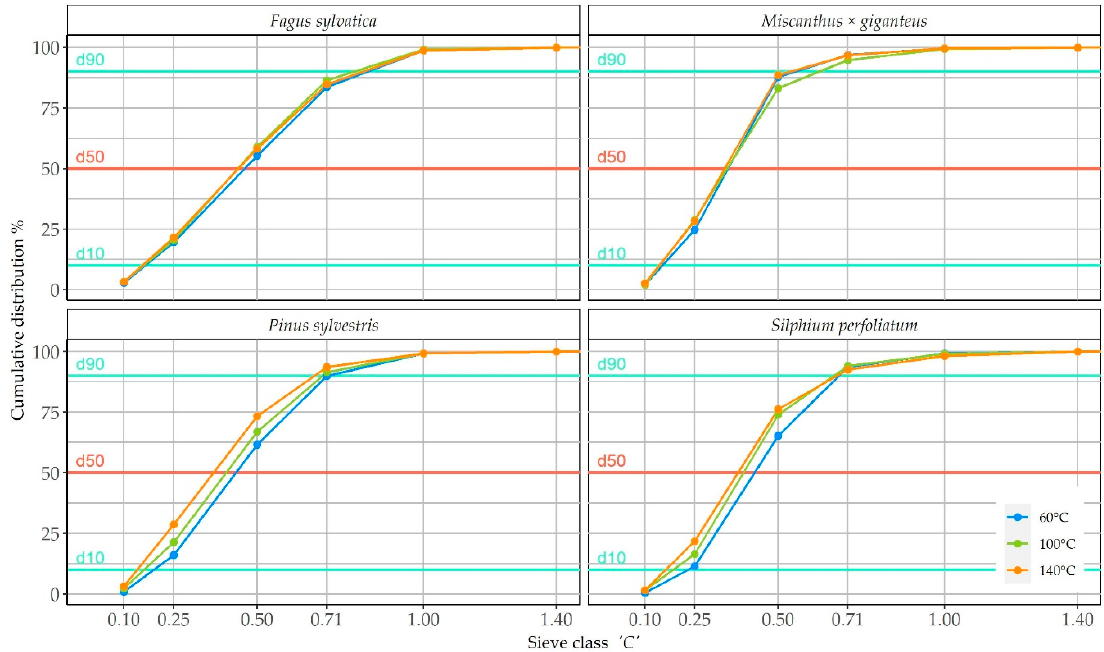
Figure 3. Cumulative particle size distribution (cPSD) raw materials ground with the knife milling system.